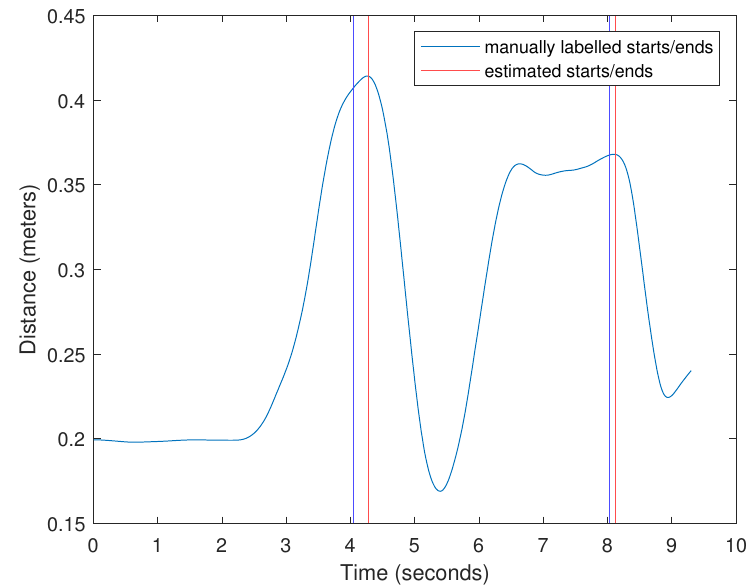
Figure 4. Lift start/end detection using the distance from the center of mass to the